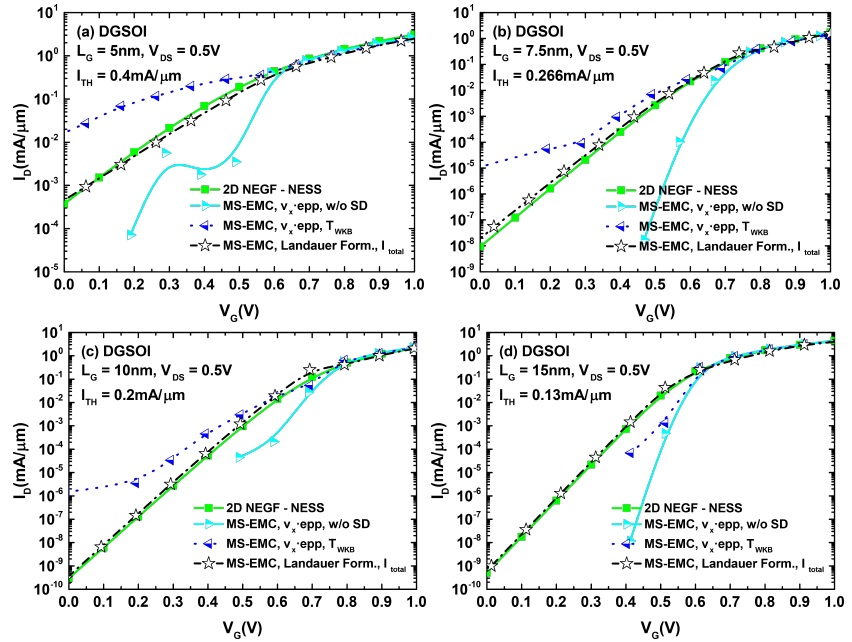
Figure 9. I D − V G characteristics for the DGSOI device with ( a ) L G = 5 nm, ( b ) L G = 7.5 nm, ( c ) L G = 10 nm, and ( d ) L G = 15 nm. The displayed current curves correspond to: NEGF, MS-EMC with the standard current computation (with and without S/D tunneling), and MS-EMC using the Landauer